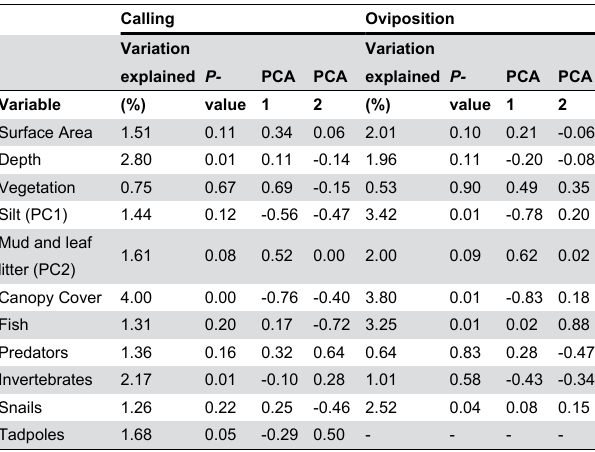
Table 2. Percent variation explained, P -value, and coordinates for the first two axes (PCA1 and PCA2) for environmental variables from partial correspondence